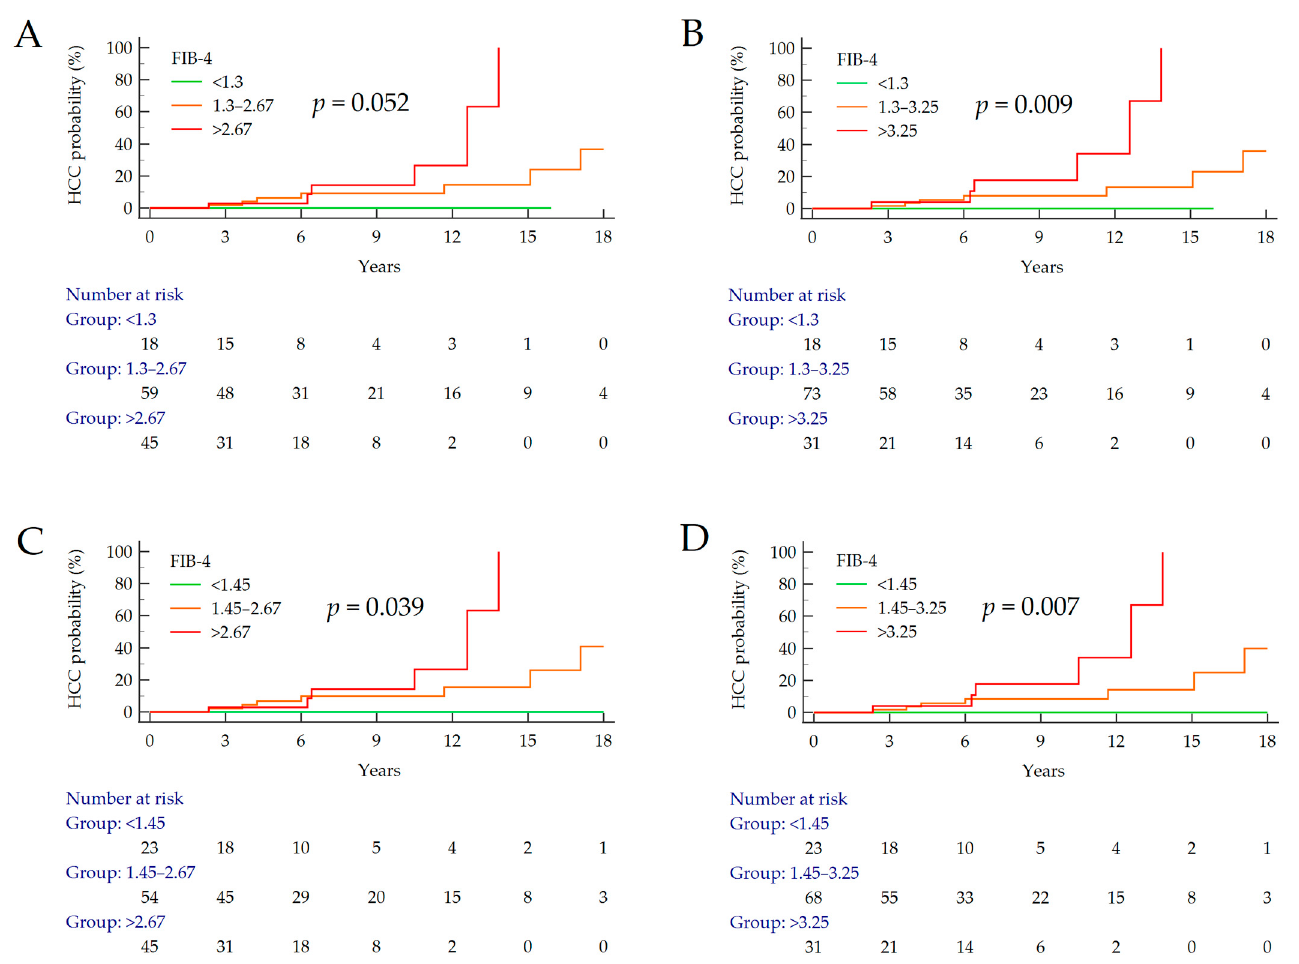
Figure 3. FIB-4 survival curves according to different cut-off combinations ( A : 1.3 and 2.67; B : 1.3 and 3.25; C : 1.45 and 2.67; D : 1.45 and 3.25). p values were calculated using log-rank test. Abbreviations: FIB-4, fibrosis 4; HCC, hepatocellular carcinoma. Table 3. Multivariate adjusted Cox regression analysis for baseline factors associated with HCC development. Hazard ratios and 95% CIs of outcome by risk score category.